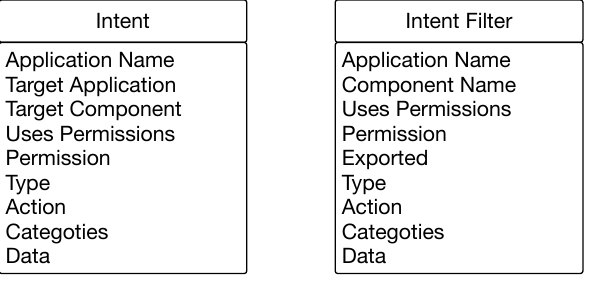
Figure 4. Intent and Intent